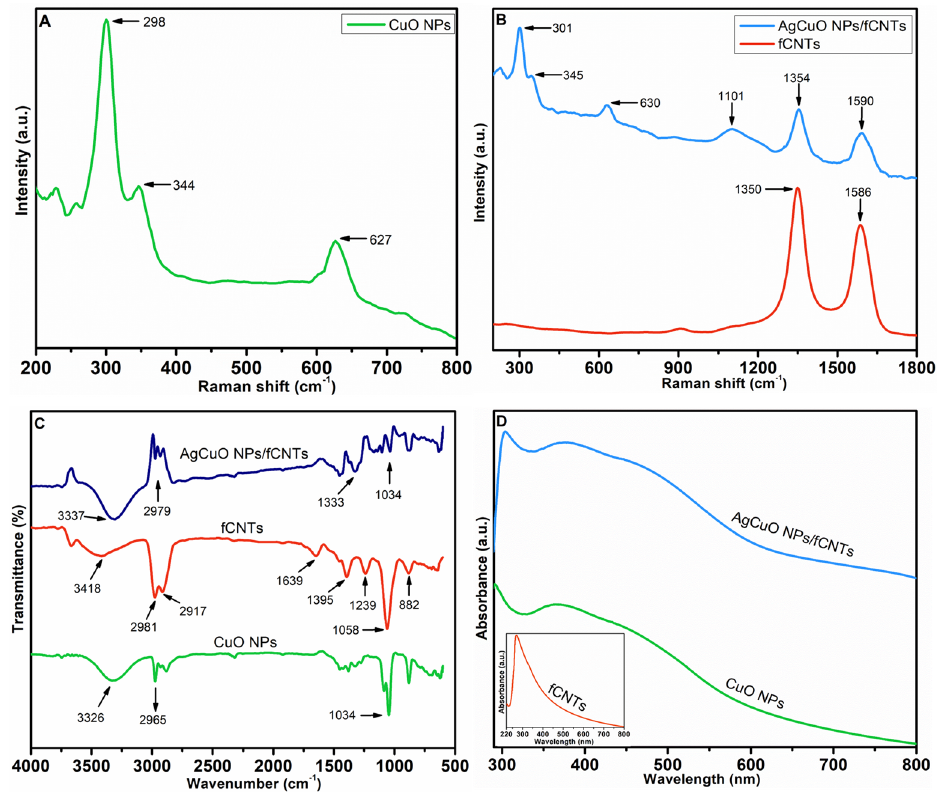
Figure 4. Raman spectrum: ( A ) CuO; ( B ) fCNTs and AgCuO NPs/fCNTs. ( C ) FTIR spectrum: CuO, fCNTs, and AgCuO NPs/fCNTs. ( D ) Absorbance spectrum of CuO and AgCuO NPs/fCNTs. Inset shows spectra of fCNTs.